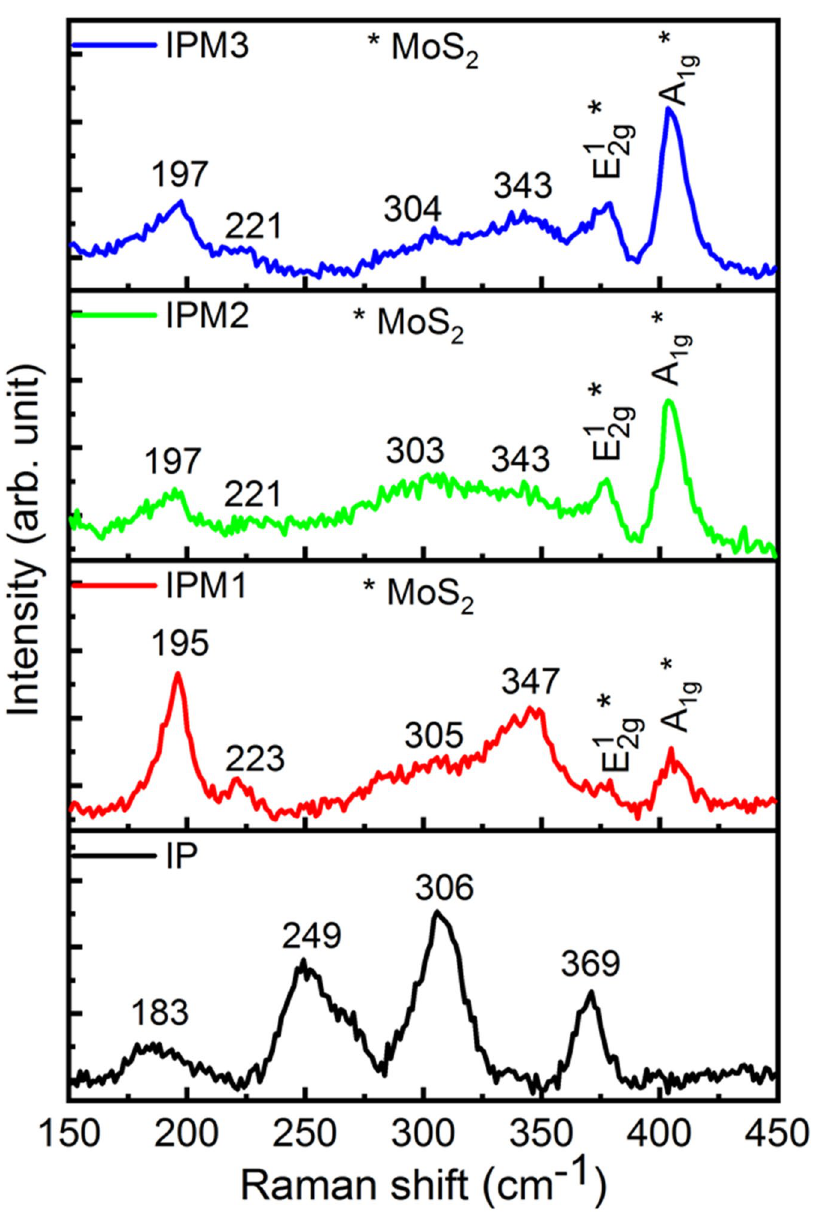
Figure 3. Raman results of In 2 S 3 nanosheets and In 2 S 3 –MoS 2